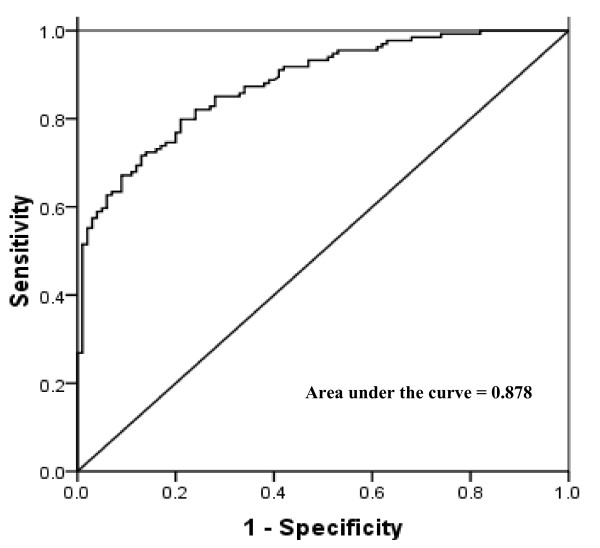
Receiver-operating characteristics (ROC) curve to calculate sensitivity and specificity of plasma VEGF levels as a tumor marker in advanced non-small cell lung cancer.